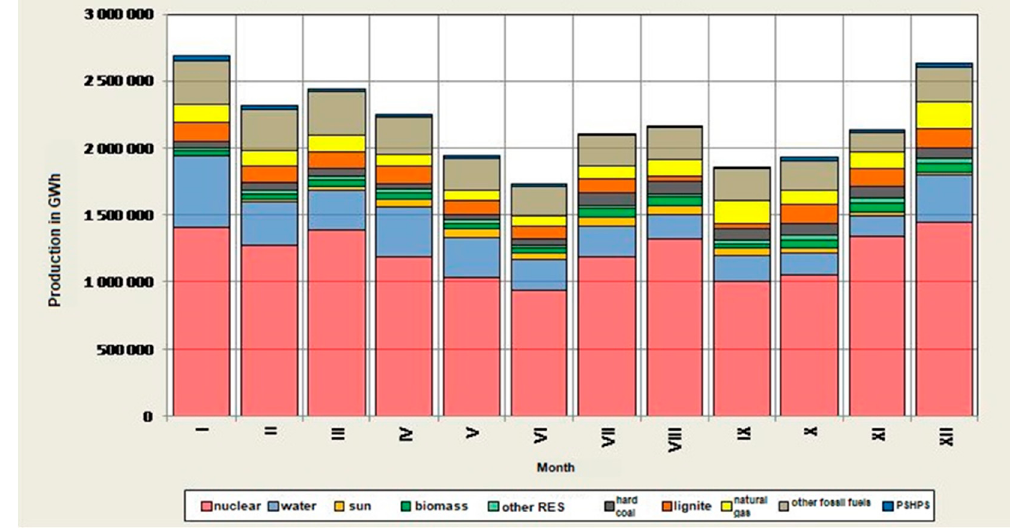
Figure 9. Electricity production for heating at sources in Slovakia in 2018 (Source: [35]).